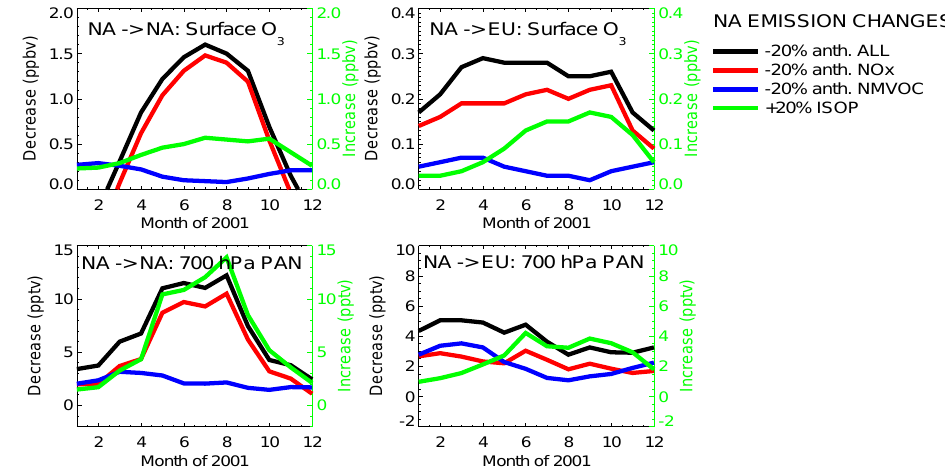
Fig. 4. Monthly mean regional (left) and intercontinental (right) 1 O 3 ANTH in surface air (top) and 1 PAN ANTH at 700hPa (bottom), as determined by differencing the spatially averaged surface O 3 over NA and EU (Fig. 1) in the baseline simulation and in sensitivity simulations in which NA anthropogenic emissions of NO x (red), NMVOC (blue), and all O 3 precursors combined (black) are decreased by 20% (left axis). Also shown are 1 O 3 ISOP and 1 PAN ISOP (green; right